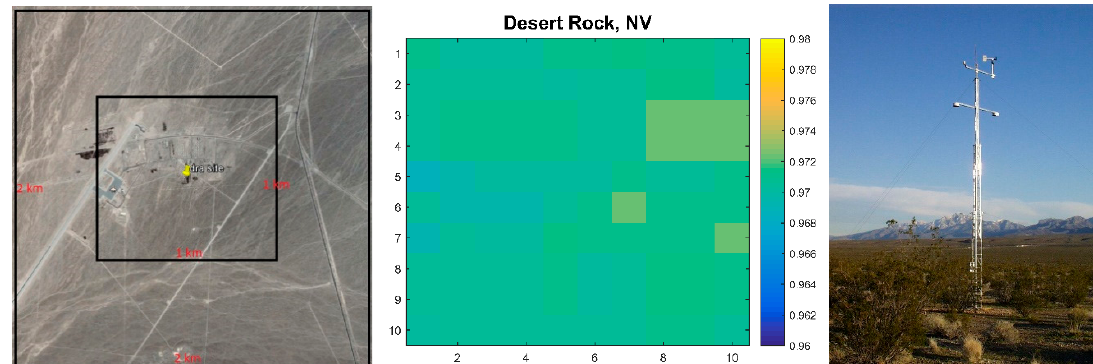
Figure 10. Satellite view of the 2 km by 2 km (whole map) and 1 km by 1km box (black) near the Desert Rock (left); middle figure shows the emissivity within 1 km of the site using ASTER GED data; right figure shows the tower with pyrometer mounted for measuring upwelling radiance.